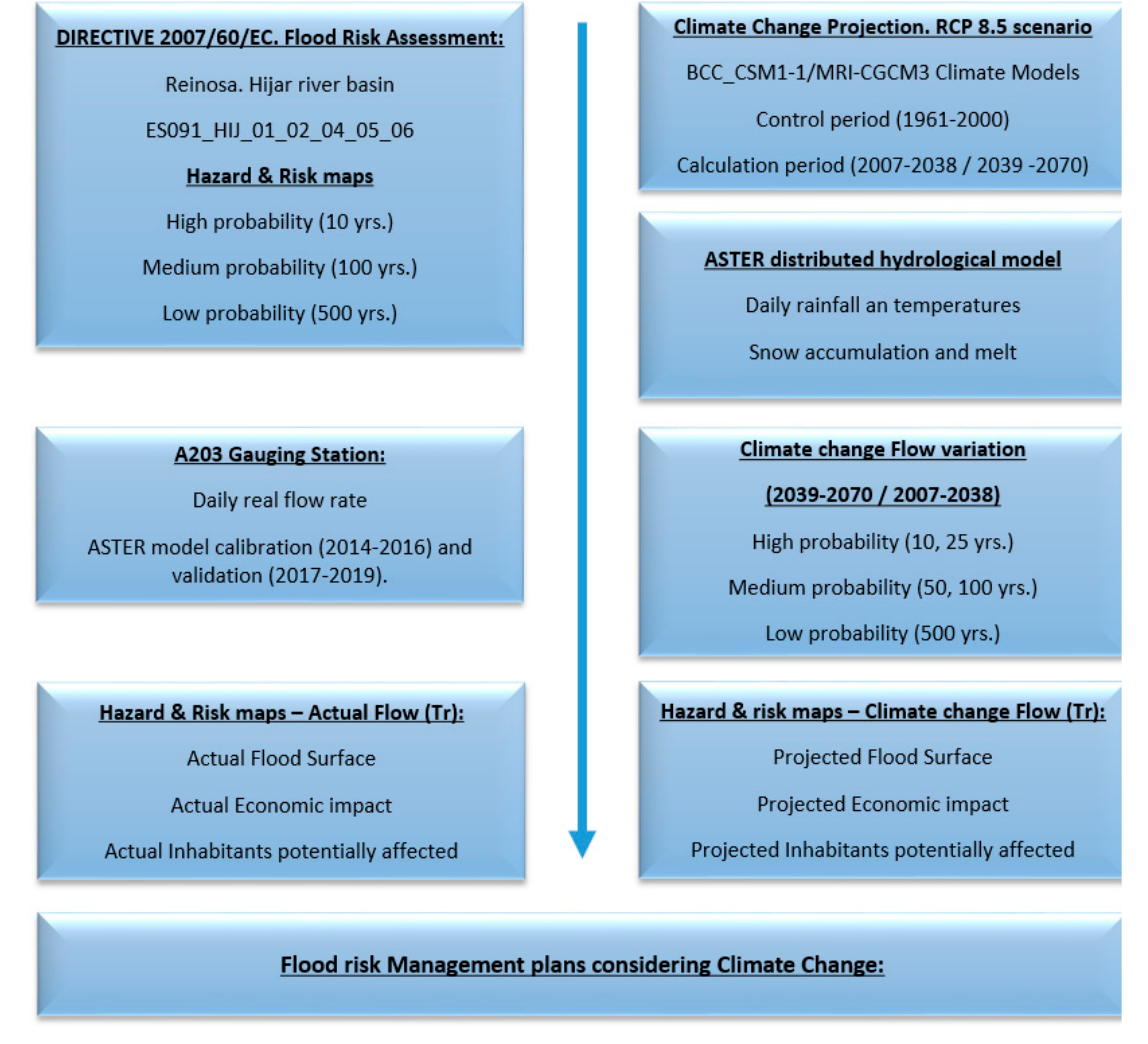
Figure 4. Overall methodology scheme.